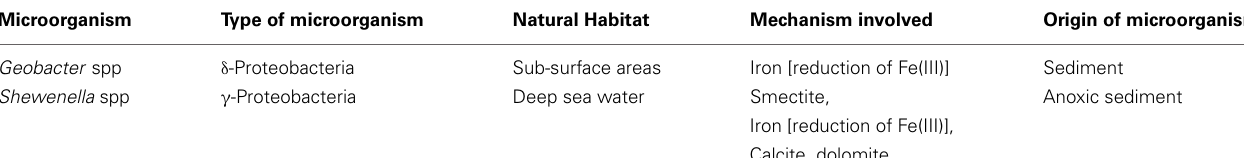
Table 1 | Ability of Geobacter and Shewenella species to solubilize minerals (Kato and Nogi, 2001; Uroz et al., 2009).